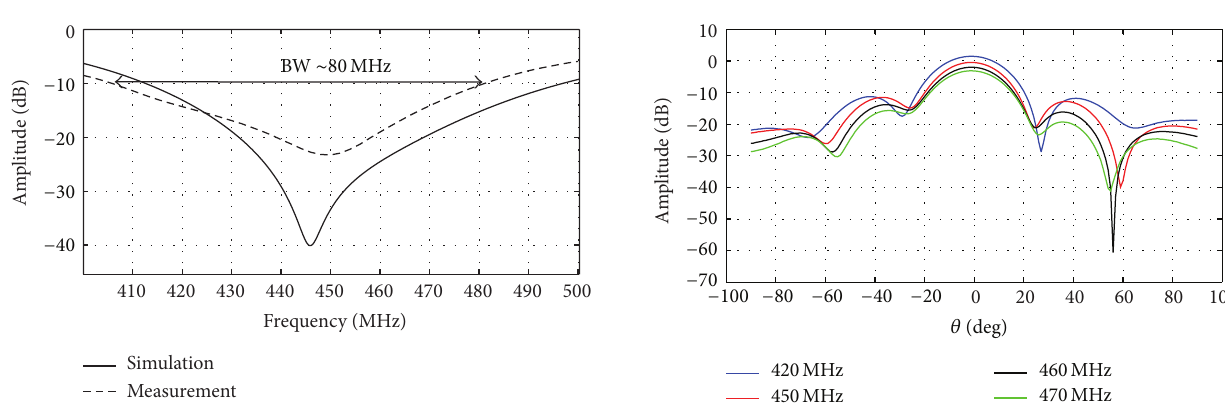
Figure 8: Measured radiation pattern of SAR-Low antenna: copolar component at different frequencies.